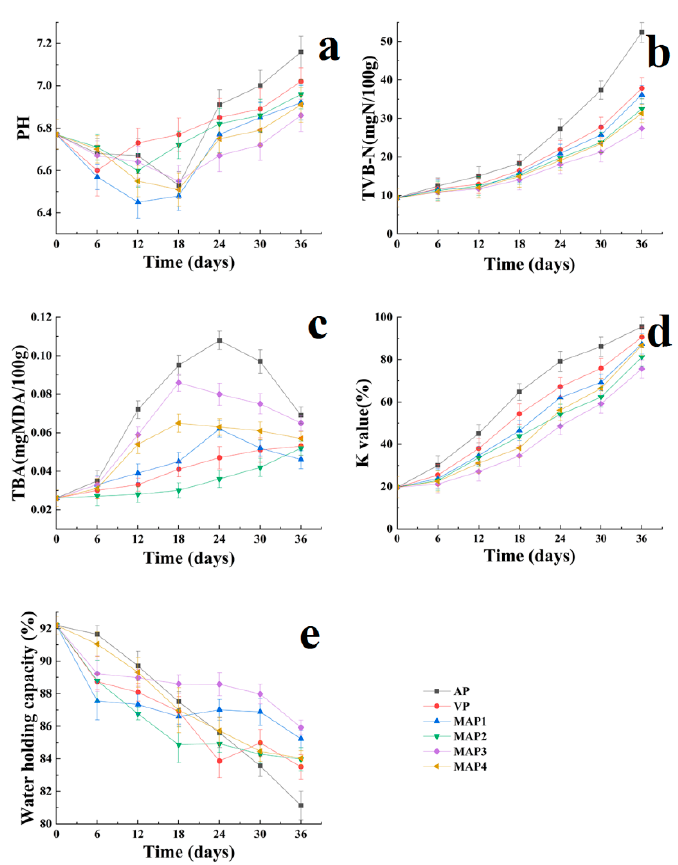
Figure 2. Changes in pH values ( a ), total volatile basic nitrogen (TVB-N) values ( b ), thiobarbituric acid reactive substances (TBARS) values ( c ), K values ( d ), and water holding capacity (WHC) values ( e ) of Chinese sea bass during superchilling storage at − 0.9 °C. AP: air package; VP: vacuum package; MAP1: modified atmosphere packaging with 40% CO 2 /60% N 2 ; MAP2: modified atmosphere packaging with 40% CO 2 /10% O 2 /30% N 2 ; MAP3: modified atmosphere packaging with 60% CO 2 /10% O 2 /30% N 2 ; MAP4: modified atmosphere packaging with 60% CO 2 /40% N 2 .